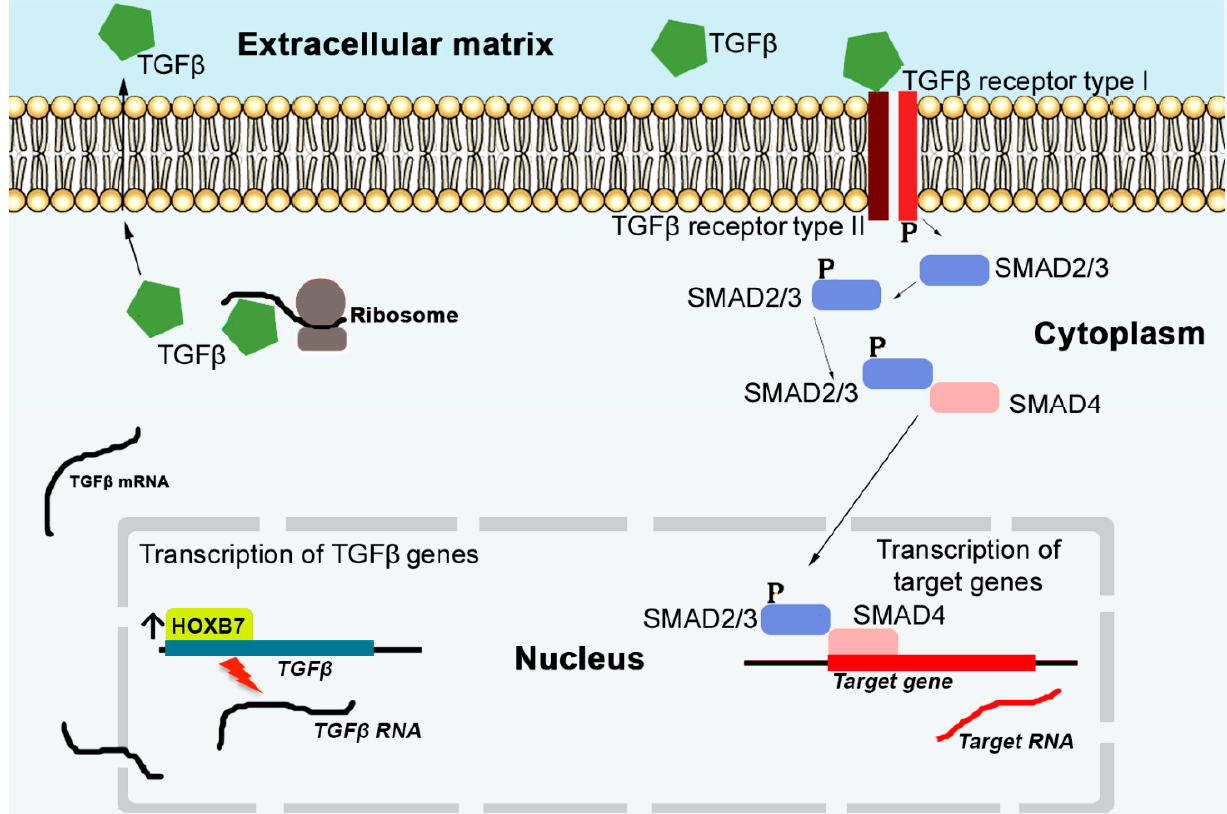
Figure 3 . TGF β signalling pathway in breast cancer cells. The reception of the TGF β signals by the TGF β receptor type II allows the phosphorylation of the TGF β receptor type I. Subsequently this favour the phosphorylation of SMAD2/3 proteins that can in turn interact with the protein SMAD4. This complex of proteins controls the expression of TGF β target genes, affecting cellular processes, such as proliferation, apoptosis, metastasis, and angiogenesis. The expression of the TGF β ’s genes is regulated by HOX transcriptional factors, as HOXB7 in breast cancer. After its transcription (nucleus) and translation (cytoplasm), TGF β ligands are exported to the ECM, where they recognize and are recognized by TGF β receptors type II.